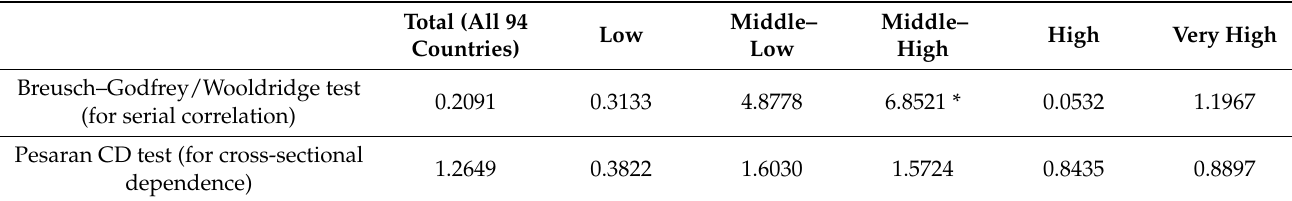
Table 8. Robustness checks for the dynamic (one-way) panel models with fixed effects estimator and Driscoll–Kraay standard